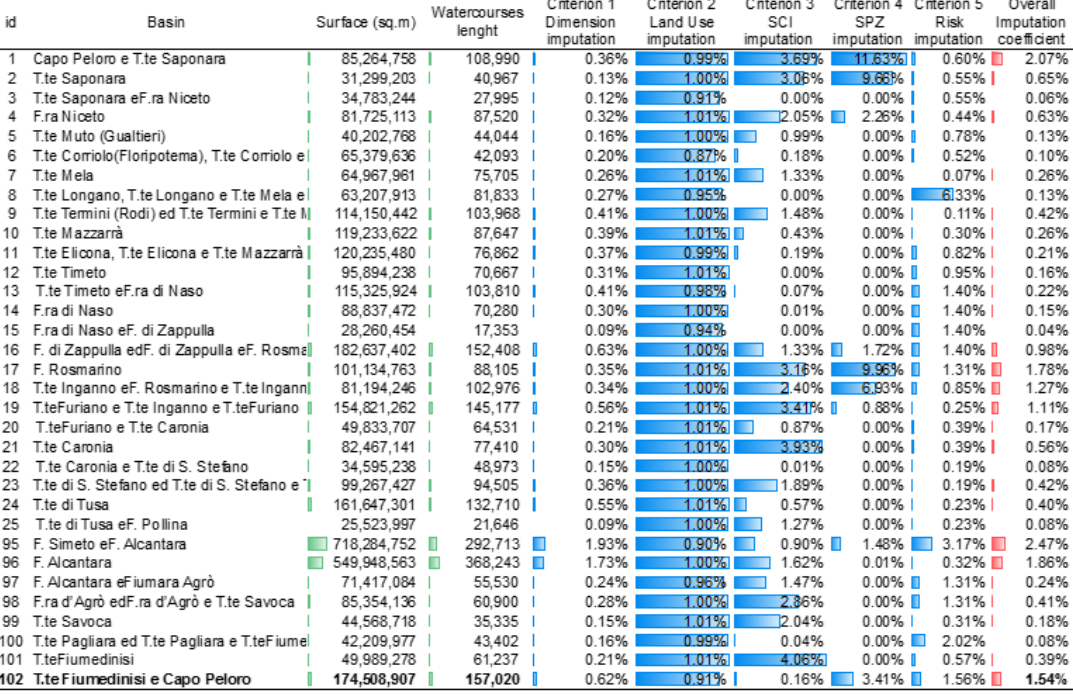
Figure 11. Synthesis of the coefficient of imputation calculated for the river basins in the Messina Province according to the four criteria (river basins 26-94